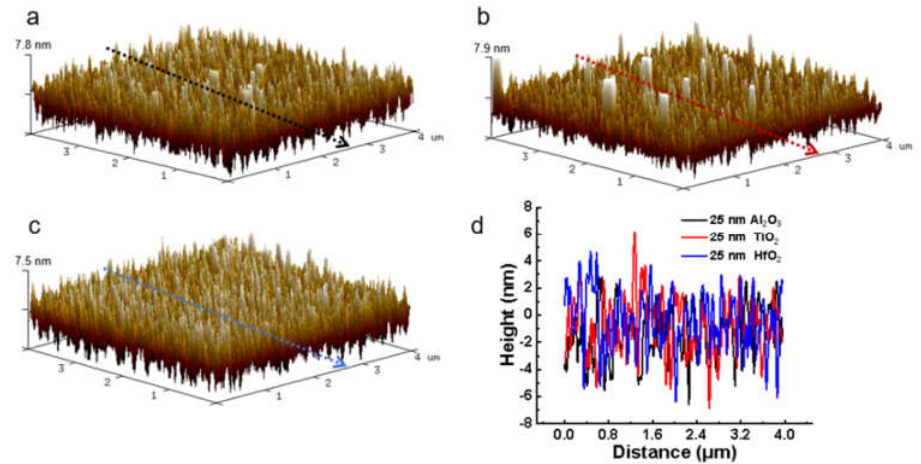
Figure 3. AFM images of MIM capacitors deposited with 25 nm Al 2 O 3 , TiO 2 , and HfO 2 dielectric material, respectively. ( a ) ALD deposition of Al 2 O 3 dielectric material. ( b ) ALD deposition of TiO 2 dielectric material. ( c ) ALD deposition of HfO 2 dielectric material. ( d ) The linear contour fluctuations in the directions are indicated by the black, red, and blue lines in Figure 3a–c.